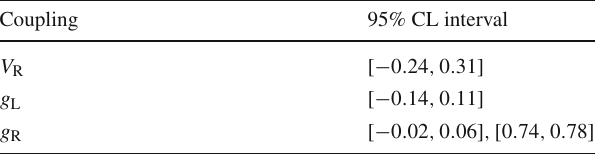
Table 5 Allowed ranges for the anomalous couplings V R , g L , and g R at 95% CL. The limits are derived using the measured W helicity fractions using the leptonic analyser for events with ≥ 2 b -tags (combination of the two channels, electron and